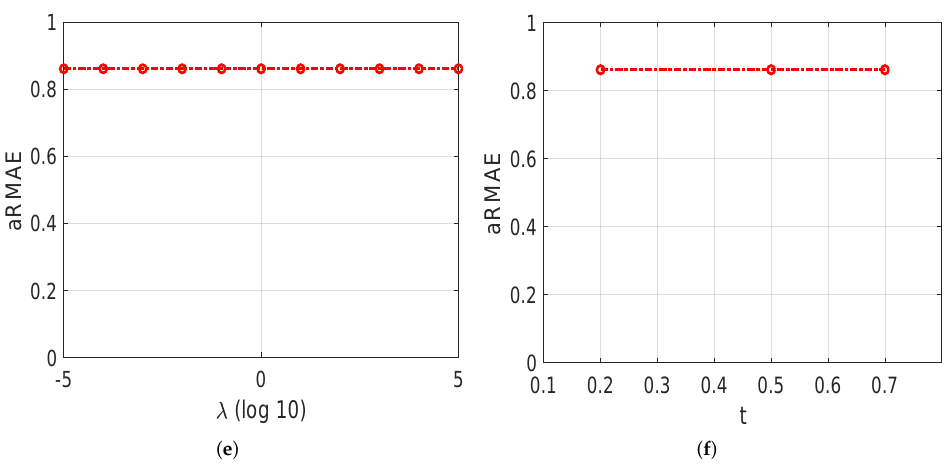
Figure 2. Sensitivity analysis about GCMoL with different λ and t . ( a ) Micro-F1 scores of different λ on CAL500 dataset. ( b ) Micro-F1 scores of different t on CAL500 dataset. ( c ) Macro-F1 scores of different λ on CAL500 dataset. ( d ) Macro-F1 scores of different t on CAL500 dataset. ( e ) aRMAE of different λ on edm dataset. ( f ) aRMAE of different t on edm dataset.